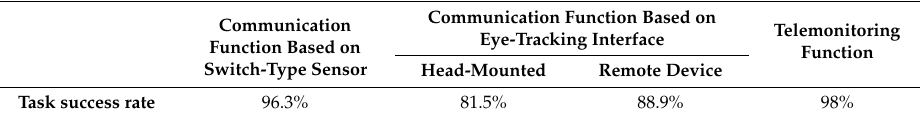
Table 4. Task success